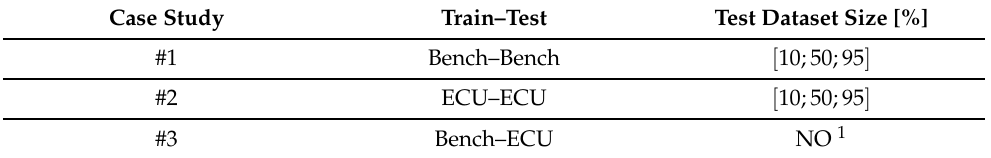
Table 2. Steady-state case analysis based on datasets and train–test split